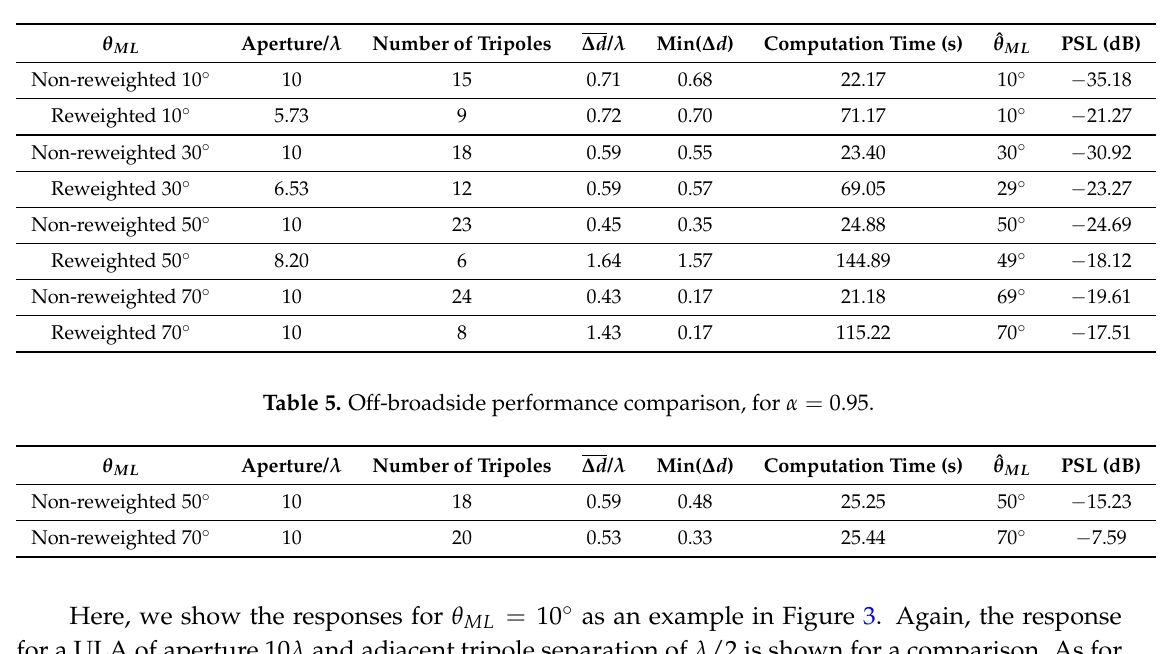
Table 4. Off-broadside performance comparison, for α = 0.5.